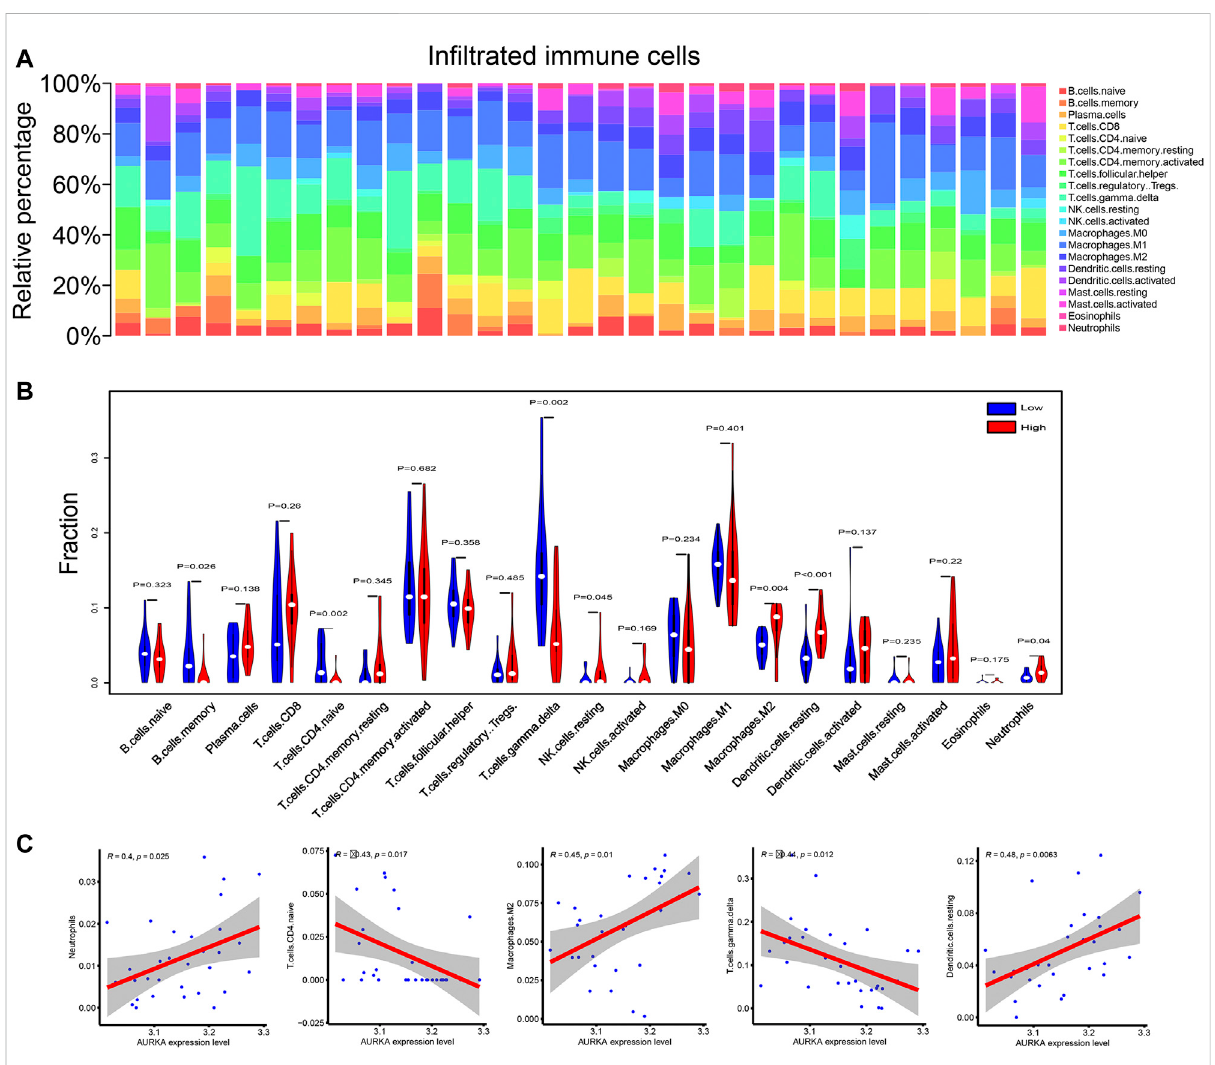
FIGURE 9 Immune in fi ltration correlation analysis. (A) . Panorama of immune cell in fi ltration in 21 tumor samples; (B) . Violin plot comparing immune cell in fi ltrationbetween AURKA highandlowexpressiongroups; (C) .Correlationdiagramof AURKA geneexpressionandimmunecellin fi ltration. AURKA , Aurora kinase (A)